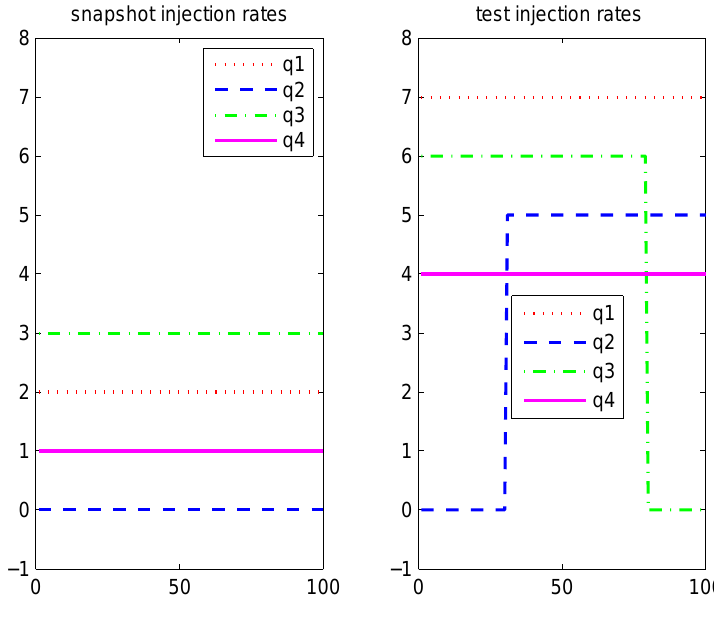
Figure 8. Injection rate schedules for training and test